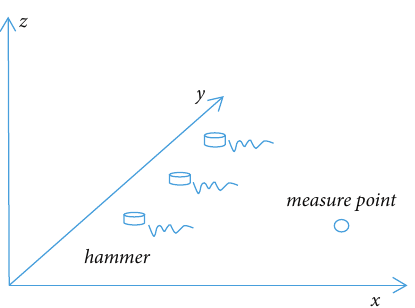
Figure 1: Multiple DCM impact energy superposition